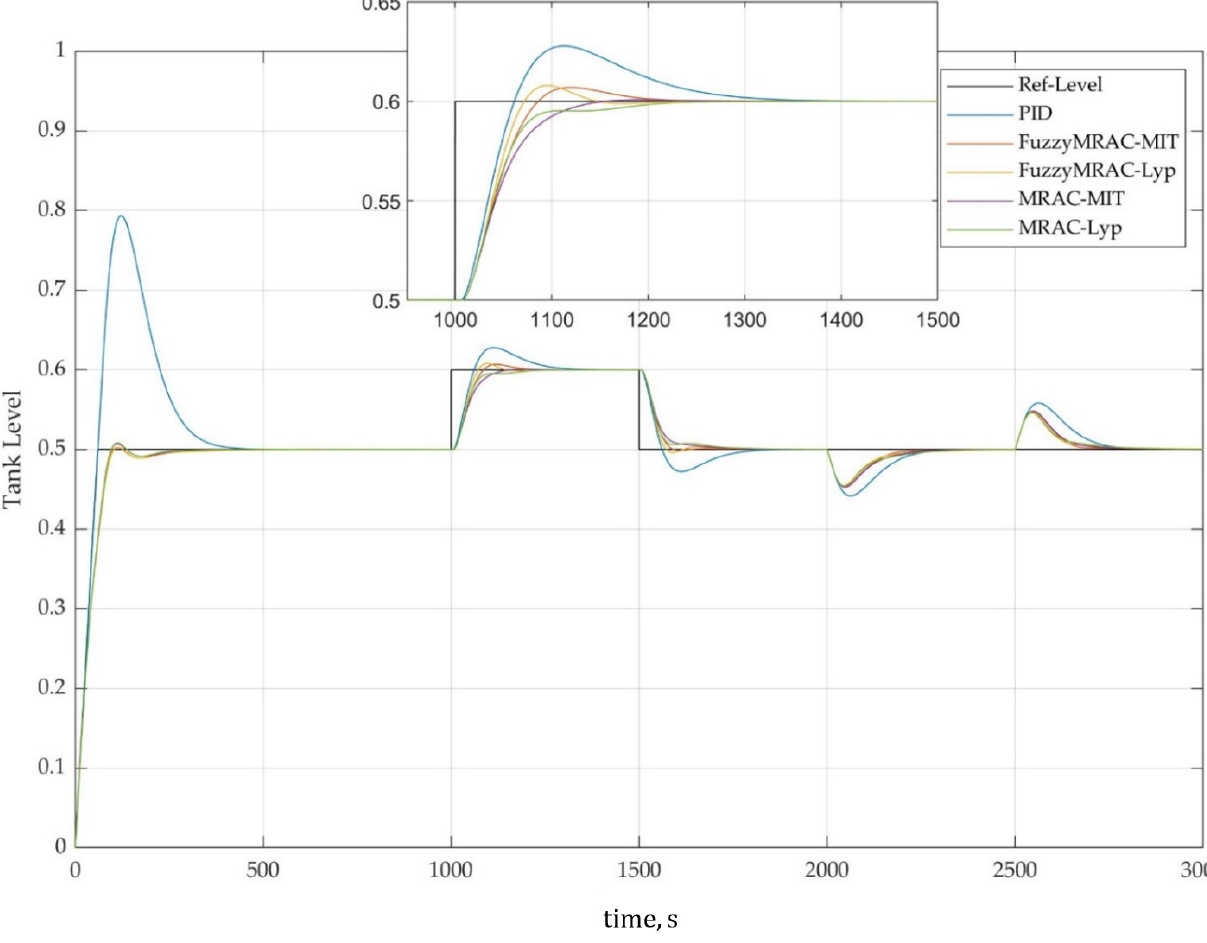
Figure 8. Gas cleaning tank system level control using PID, MRAC and fuzzy MRAC. Table 2. MIT and Lyapunov based MRAC results compared to PID.